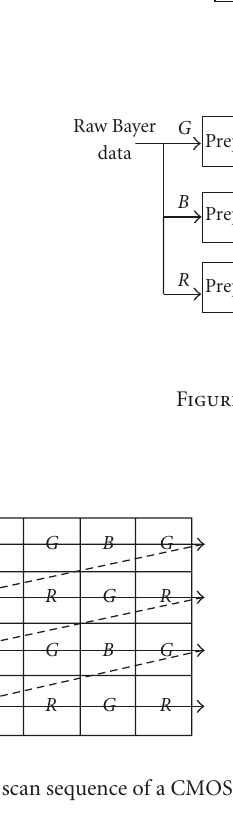
structure” needs more additional bu ff er with half image